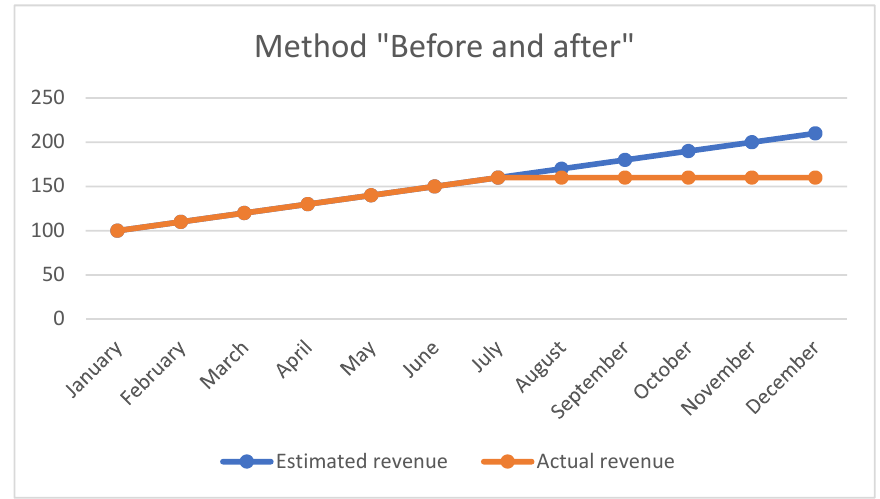
Figure 5. Graphical representation of the “Before and After” method.